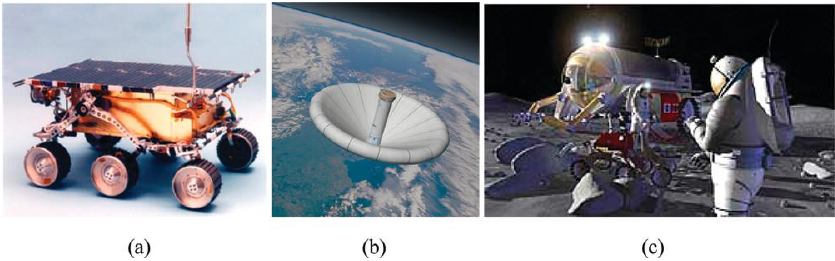
Figure 19. Current and proposed aerospace applications of aerogels, showing ( a ) Mars rover, ( b ) an inflatable decelerator concept for EDL applications, and ( c ) an EVA suit (Reprinted with permission from Ref. [93]. 2011 American Chemical Society).